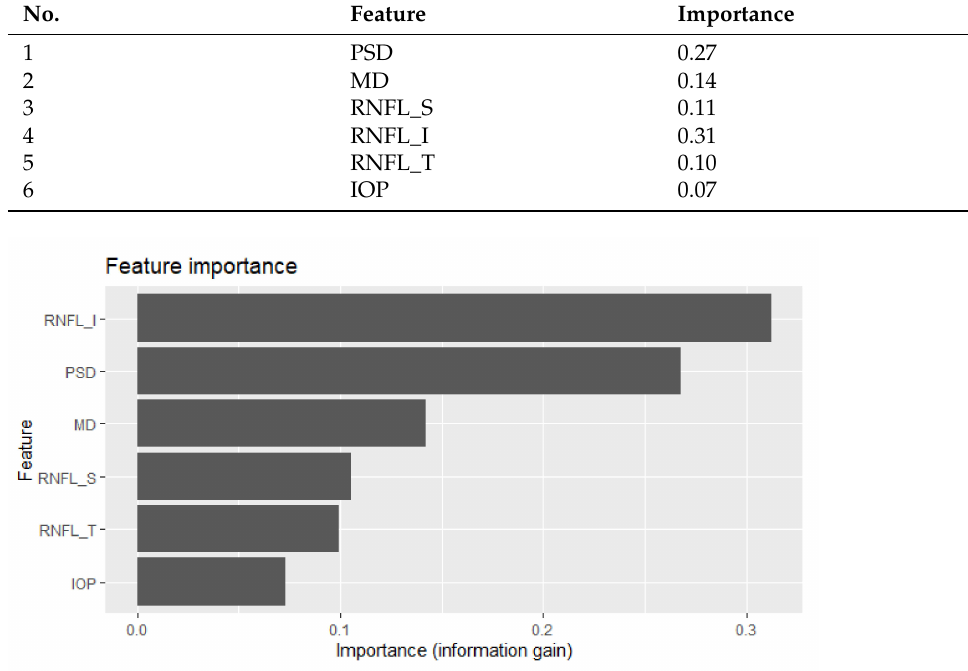
Figure 2. Graph of the feature importance of the selected features.